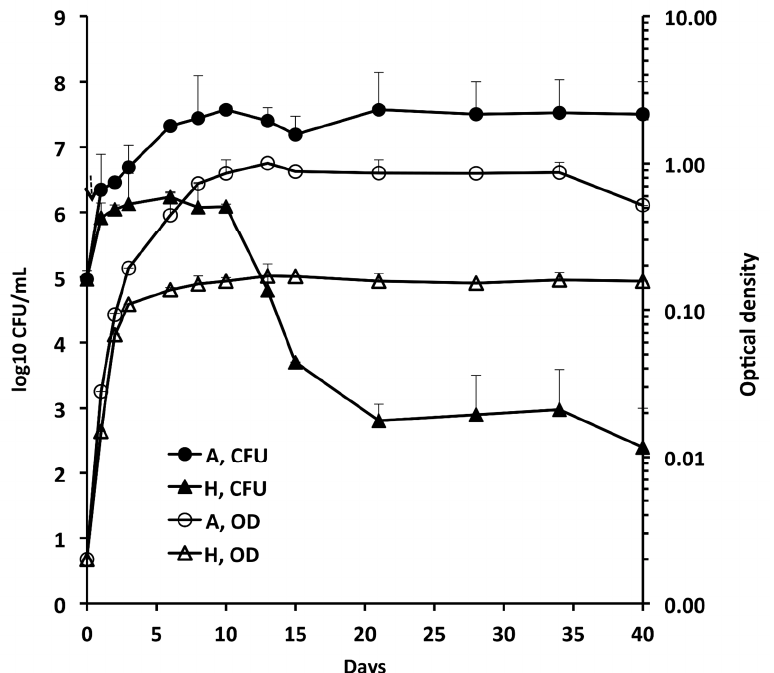
Figure 1. Growth of Mab-10 in aerobic (A), and hypoxic (H) conditions (Wayne dormancy culture model). Means ± standard deviations of colony forming units (CFU)/ml and optical density (OD) values are shown.